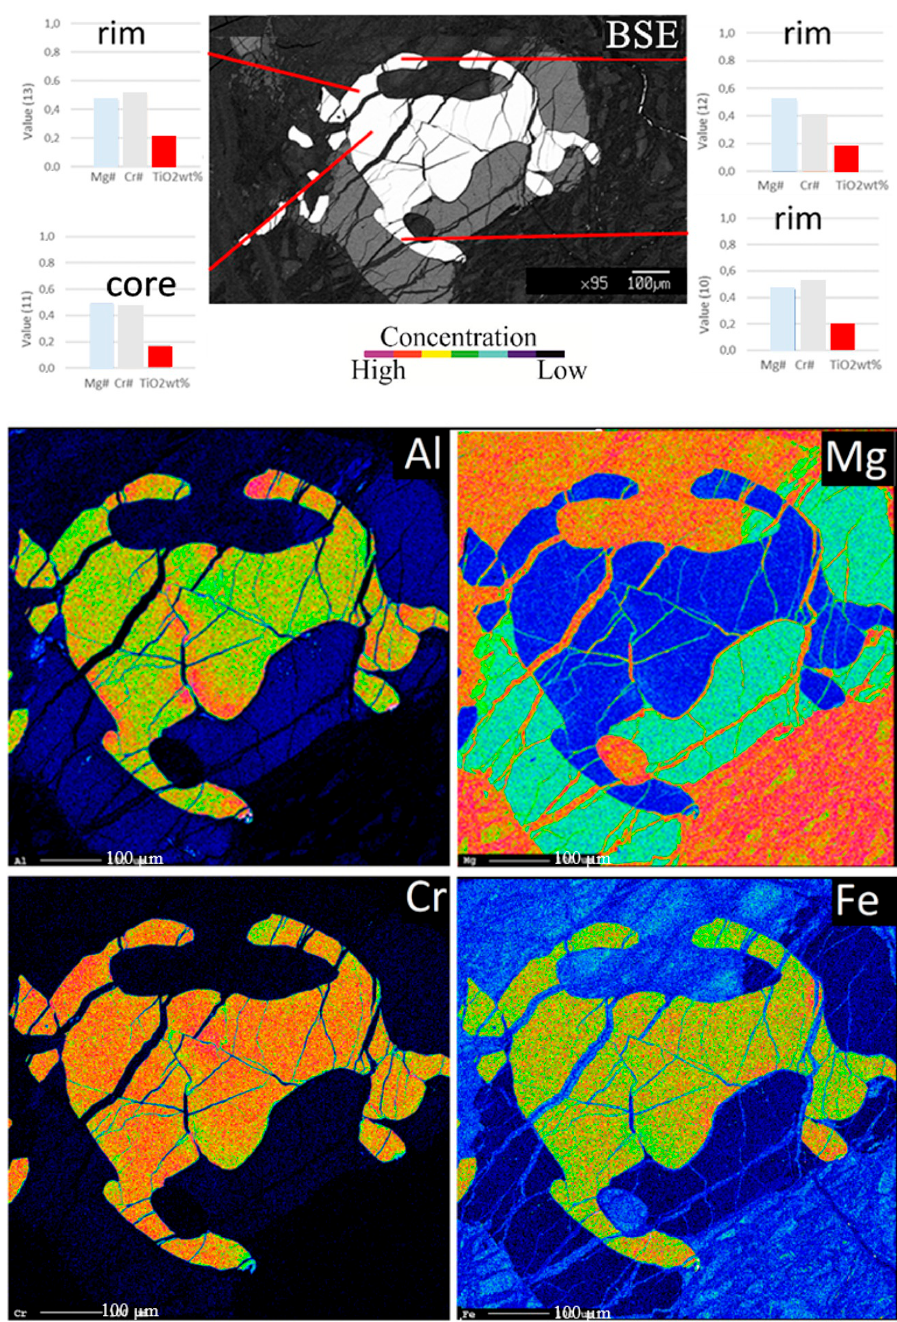
Figure 7. BA1B Hole. BSE images and X-ray elemental maps. This crystal of Cr-spinel shows a higher concentration of Al along an internal fracture, to which corresponds a depletion of Fe tot and Cr, compared to the core of the same grain. Meanwhile, the point analyses show a nearly constant amount of TiO 2 .